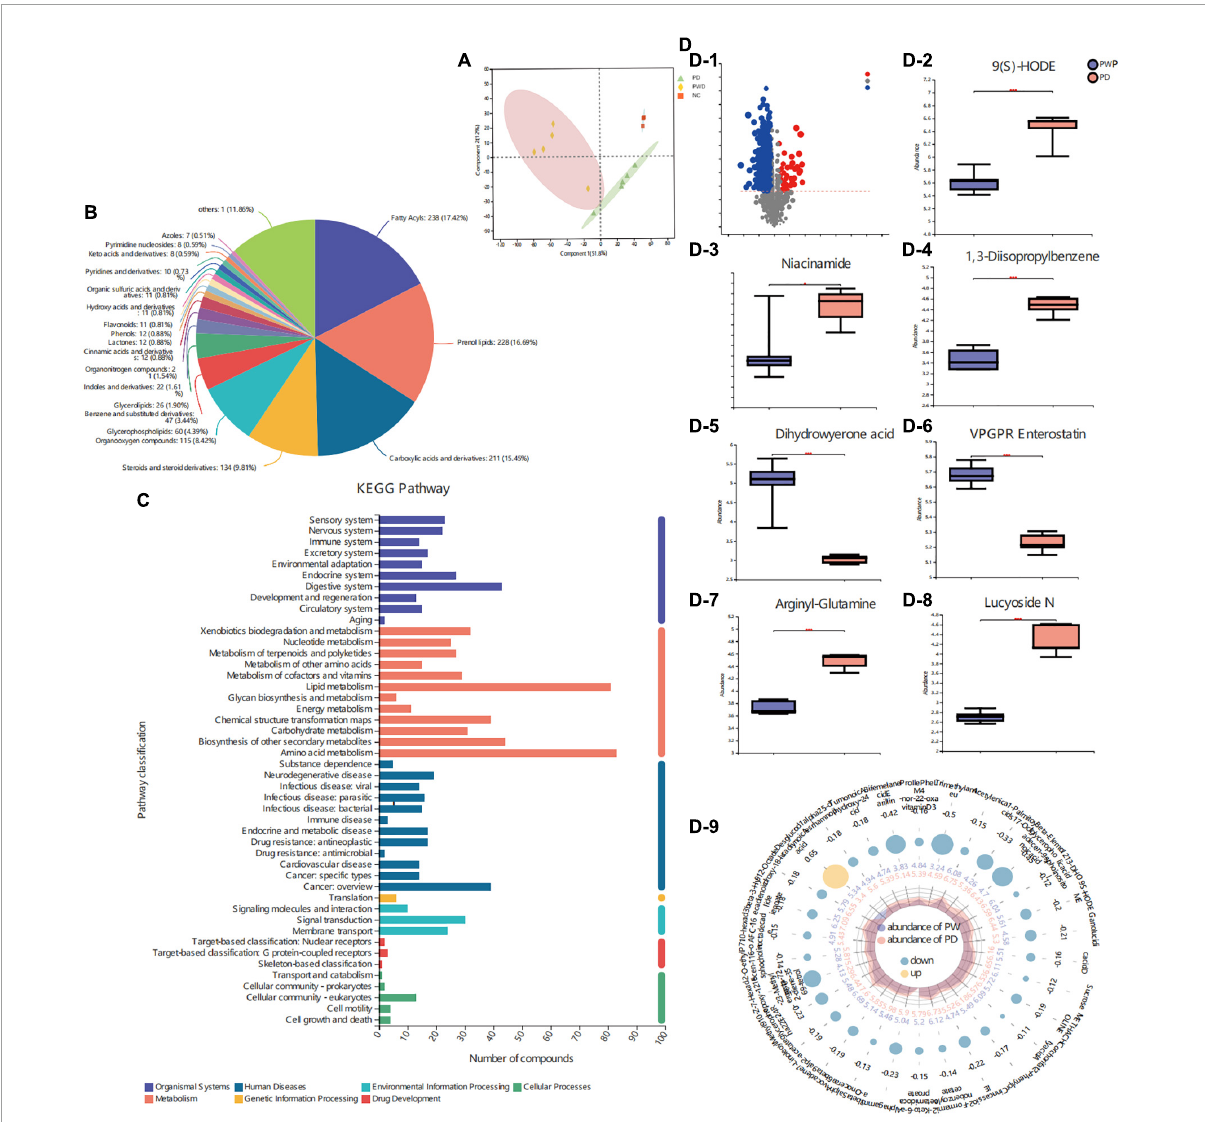
FIGURE5 The result of Fecal Metabolomics. (A) Principal component analyses (PCAs) on identified metabolites in control, PD, and PWP groups. (B) Pie chart based on counts of HMDB chemical taxonomy (class) for all metabolites detected in this study class. (C) KEGG pathway classification of metabolites detected and annotated. (D) Discrepant metabolites in comparison of the PD group and PWP